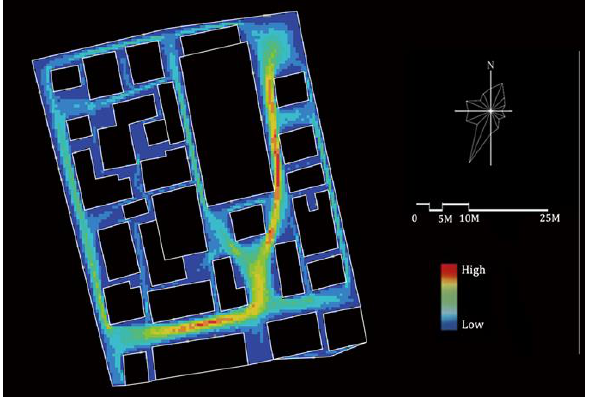
Figure 8. Integration of pedestrian flow simulation on VGA of Baoshan historical block.